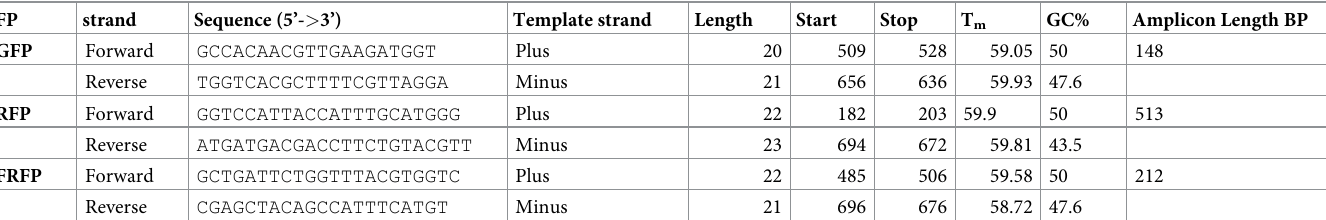
Table 1. Primer sequences used for PCR amplification and detection of plasmids encoding fluorescent proteins. FP